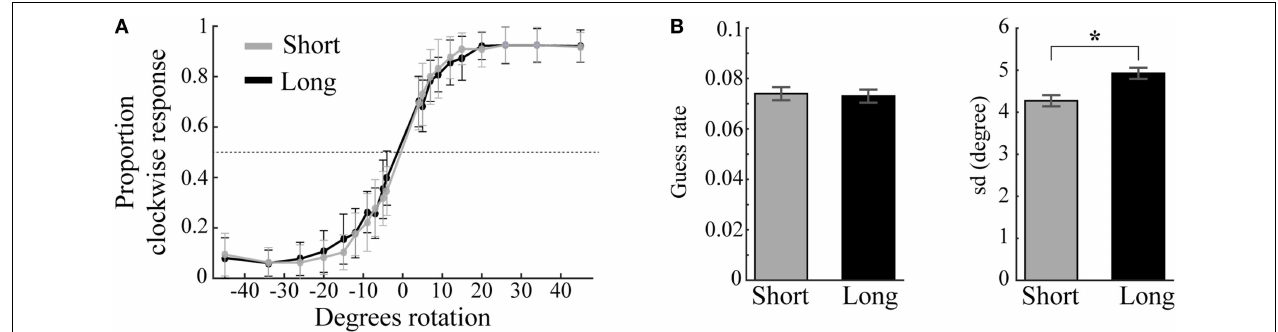
FIGURE 4 | Behavioral performance and model parameters. (A) Mean proportion of clockwise responses as a function of angle difference between memory item and probe plotted separately for short (gray) and long (black) trials. Error bars are standard deviations. (B) Guess rates and memory variability (sd) for short and long trials estimated by the standard mixture model of visual working memory (Zhang and Luck, 2008). Long trials result in significantly higher sd than short trials ( * ). Error bars are normalized standard errors.